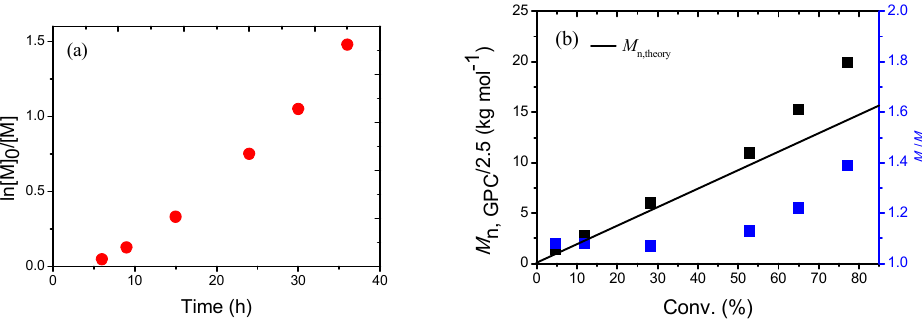
Figure 1. ln([ M ] 0 /[ M ]) as a function of time ( a ), number-average molecular weight ( M n,GPC ) and molecular weight distribution ( M w / M n ) versus monomer conversion ( b ) for photoinduced RAFT polymerization of AN under blue LED irradiation. Polymerization conditions: [AN] 0 :[CPDN] 0 :[4CzIPN] 0 = 400:1:0.01, V AN = 5.0 mL, V DMSO = 10.0 mL, under blue LED irradiation ( λ max = 458 nm, 0.85 mW · cm − 2 ).